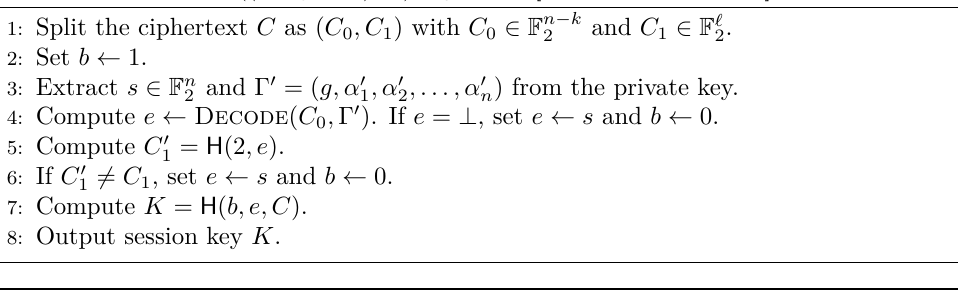
Algorithm 7 Decode ( C 0 , Γ 0 ) algorithm [ABC + 20, Sect.